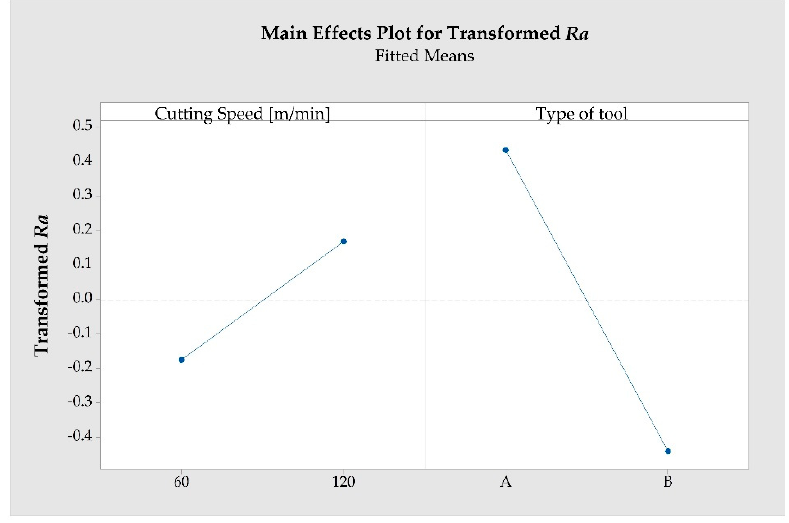
Figure 7. Effects on the transformed Ra of the significant factors.